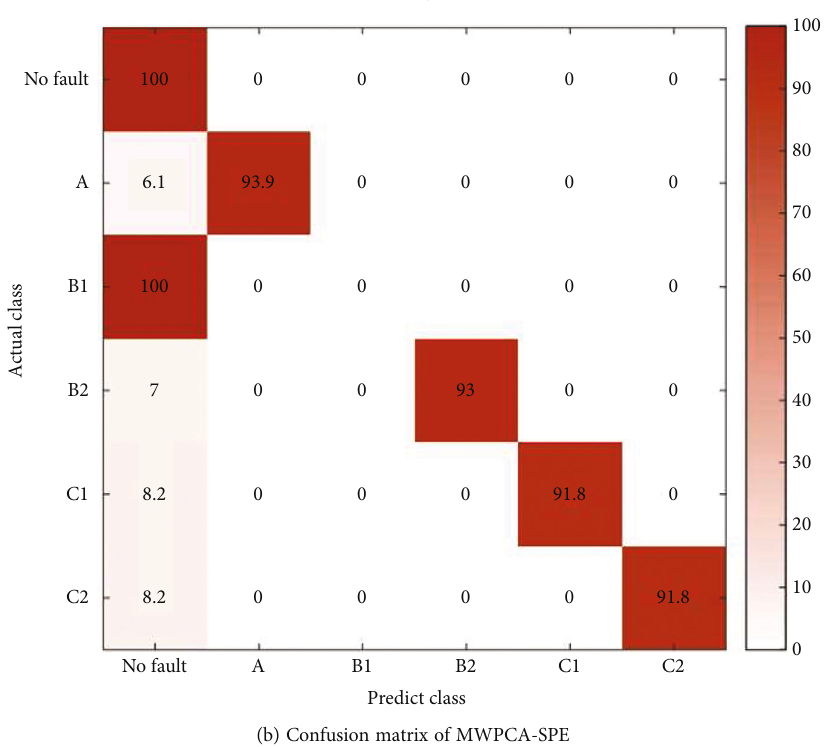
Figure 15: Confusion matrix for fault diagnosis of two